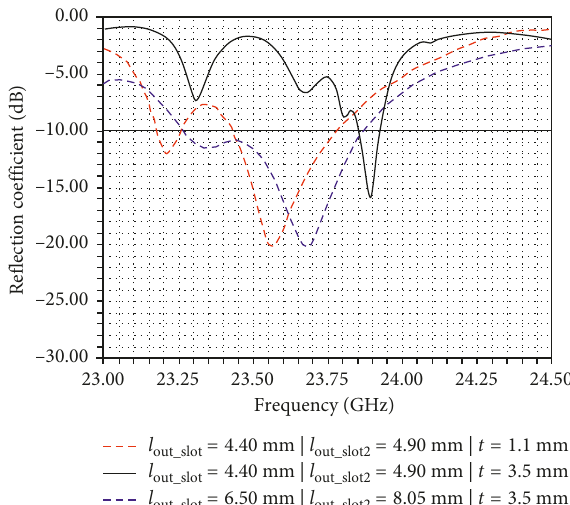
Figure 3: Reflection coefficient comparison: dashed-red and solid- black lines are conventional SWAAs with 1mm and 3.5mm waveguides thickness, respectively; the dotted-blue line is an SWAA based on trapezoidal-shaped slots with waveguide thickness equal to 3.5mm.